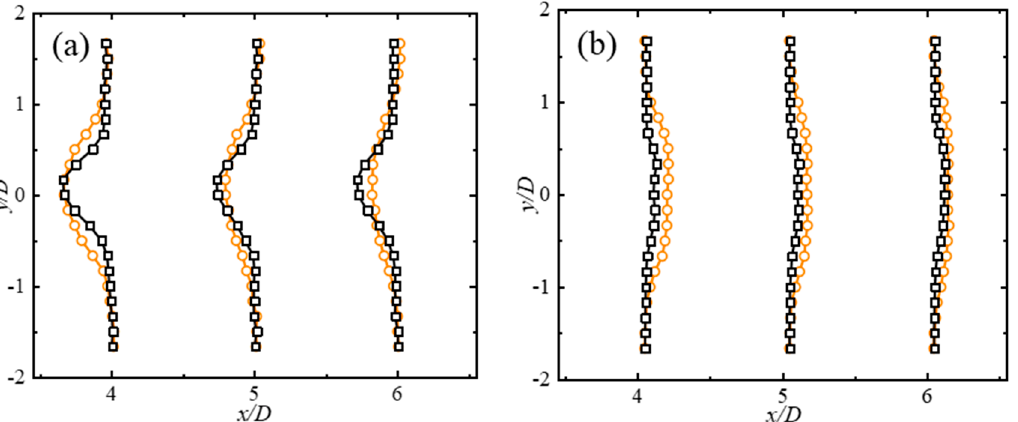
Figure 6. Wake characteristics of the geometrically similar model and the thrust-optimized model at hub height (geometrically similar model—black solid lines; thrust-optimized model—orange dotted lines). ( a ) Normalized mean velocity profile; ( b ) turbulence intensity profile.